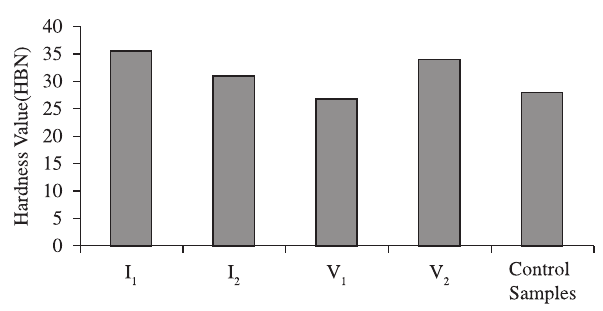
Figure 3. Average hardness values of the samples at the various welding congitions in HBN.